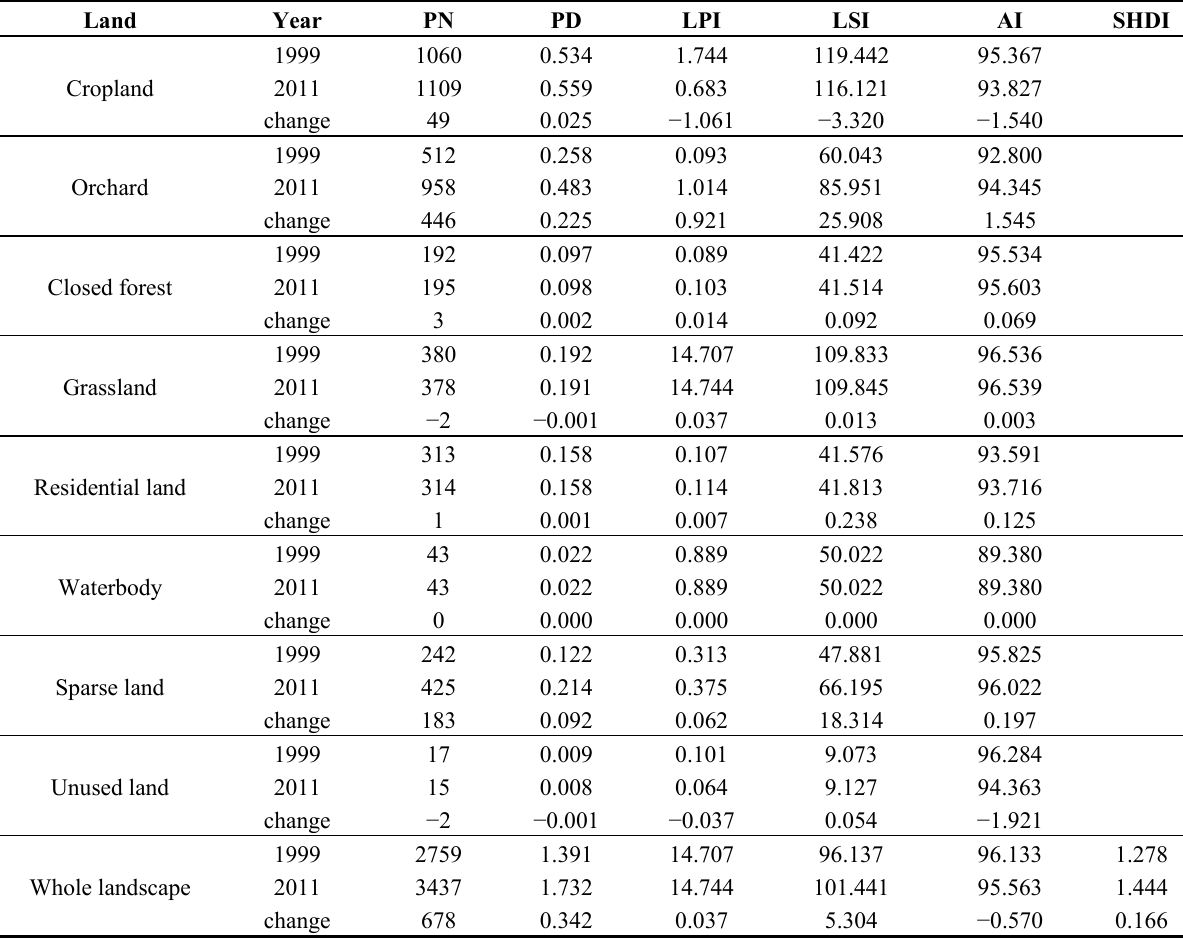
Table 6. Landscape metrics and its change in Yanchuan